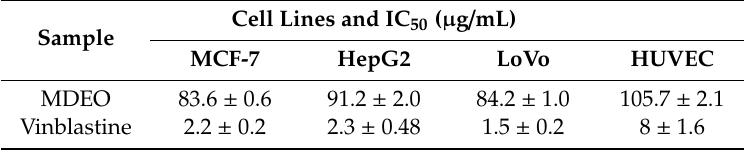
Table 2. Cytotoxic activity of Meriandra dianthera essential oil (MDEO) on three cancer cells.